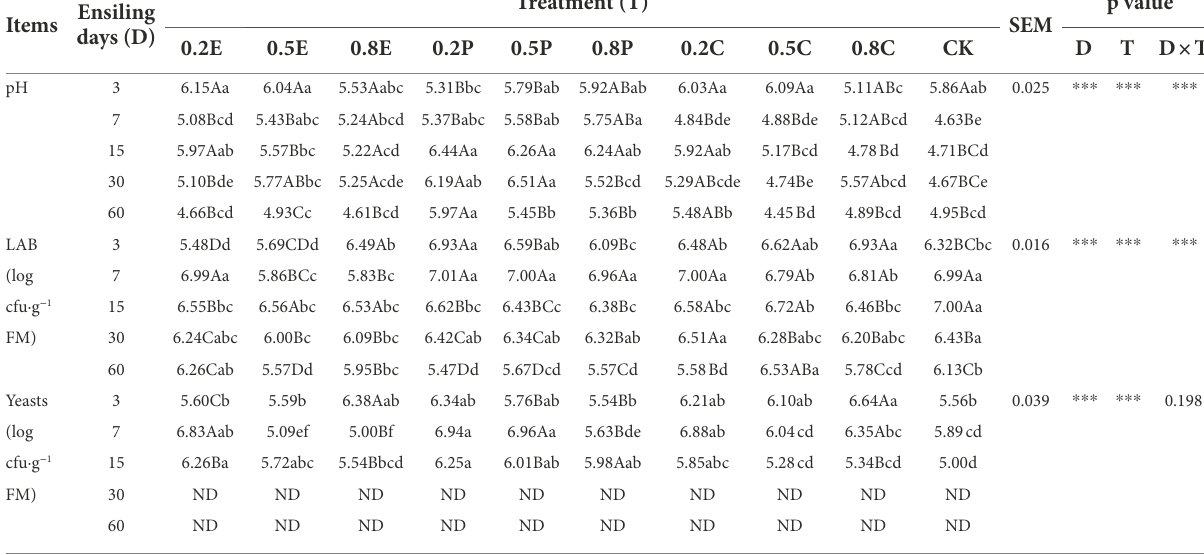
TABLE 5 Fermentative profile of paper mulberry ensiled with different treatment during fermentation. Ensiling Items days (D)